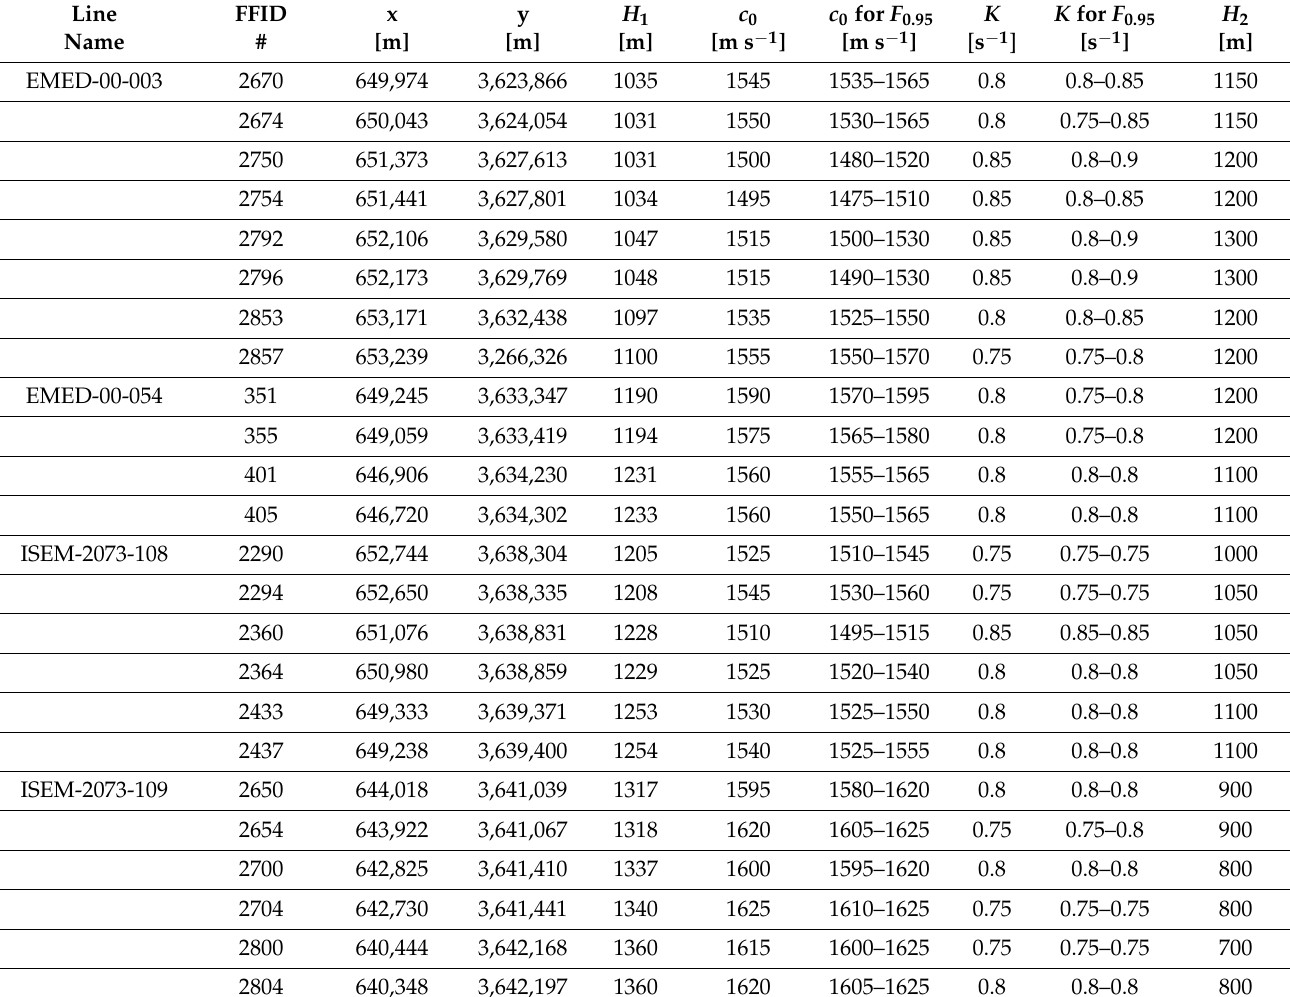
Table 1. The parameters estimated in the study area. The range of the geoacoustic parameters ( c 0 , K ) in which the normalized F ( c 0 , K , H 2 ) is >0.95 of its maximum level, F 0.95 , represents the estimation error. FFID is a Field File Identification Number, i.e., the source gather